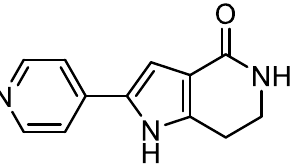
Figure 1. Chemical structure of cell division cycle 7 (CDC7) inhibitor PHA-767491 (PHA). In the last years, PHA has gained attention because it is the first CDC7 inhibitor described to prevent neurodegeneration driven by pathological phosphorylation of the